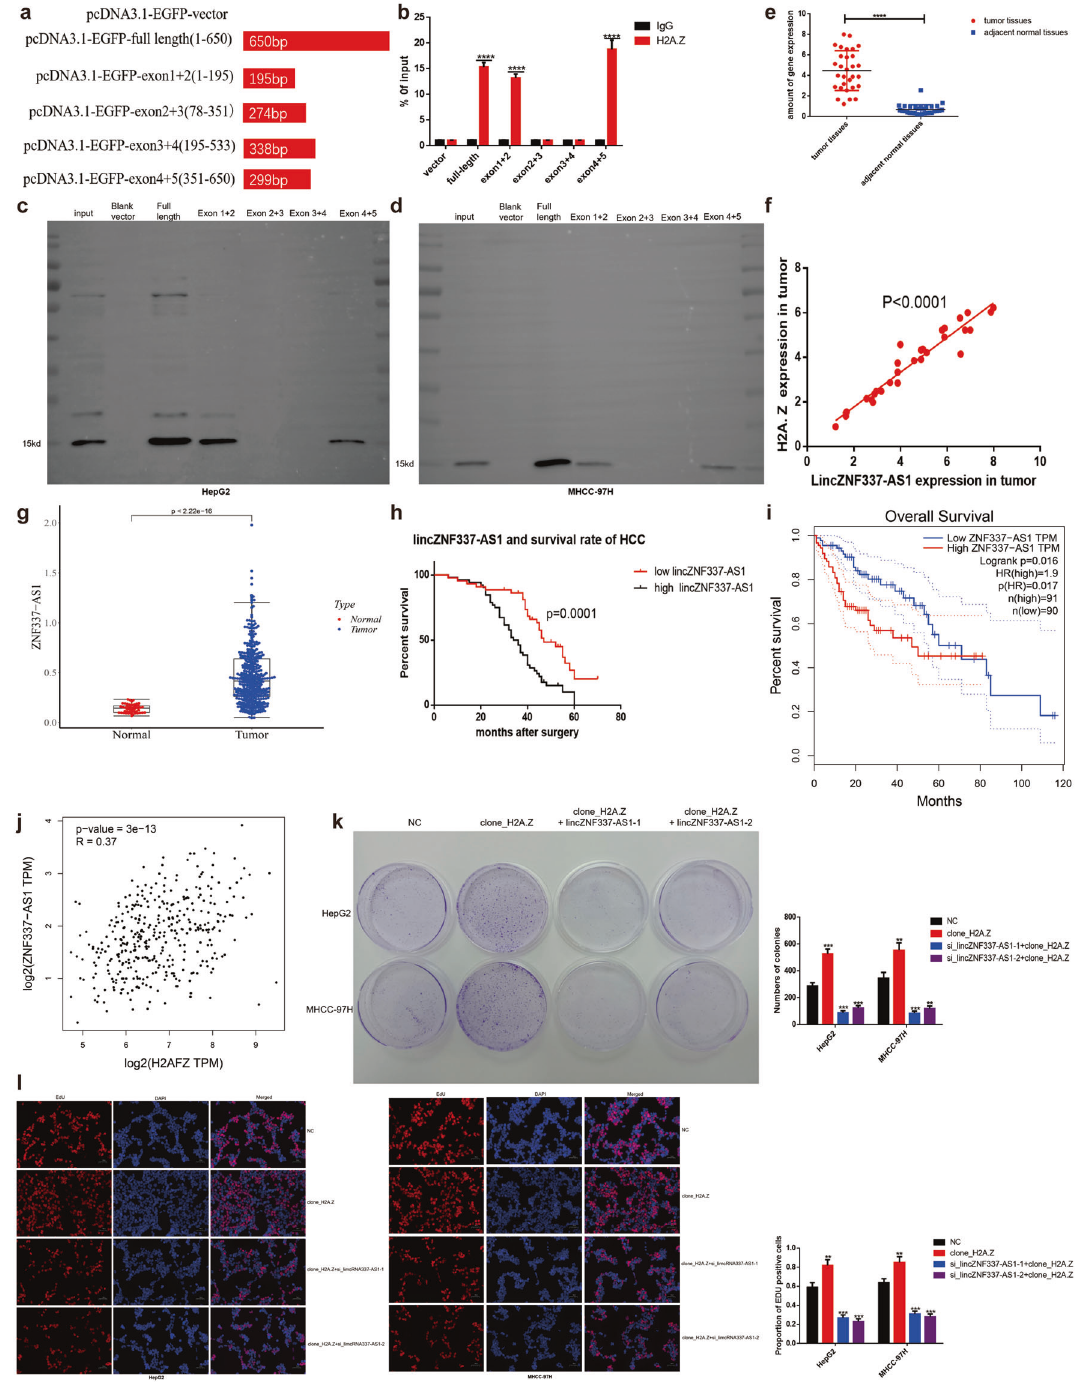
Fig. 6 Identi fi cation of lincZNF337-AS1 binding sites to H2A.Z, identi fi cation of lincZNF337-AS1 expression levels in HCC, and relationship with prognosis of HCC patients. a Schematic diagram of lincZNF337-AS1 full-length and truncated fragments. b The interaction of lincZNF337-AS1 truncated fragments with H2A.Z in HEK293T cells was veri fi ed by a RIP-qPCR assay. c , d RNA-pulldown assay veri fi es the binding site of lincZNF337-AS1 to H2A.Z in HCC cells. e Scatter plots comparing lincZNF337-AS1 expression in HCC samples and normal liver tissue samples detected by qPCR (Student ’ s t-test used in Fig e , n = 30 in each group). f The positive correlation between lincZNF337-AS1 and H2A.Z expression was analyzed on the basis of data of 30 HCC samples. g LincZNF337-AS1 transcript between HCC tissues and normal paracancer tissues was analyzed in the publicly accessible samples(TCGA http://gepia.cancer-pku.cn/, T = 375; N = 50, Software: beeswarm, R package). h Kaplan – Meier survival curves illustrating the overall survival and disease-free survival of patients with HCC associated with lincZNF337-AS1 expression in 96 cases. i The negative correlation between lincZNF337-AS1 expression and overall survival was analyzed on the basis of TCGA data in patients with HCC(Software: survival, R package). j The positive correlation between lincZNF337-AS1 and H2A.Z expression was analyzed on the basis of TCGA data in patients with HCC(Software: ggplot2, R package). k , l The proliferation capability of cells was detected by colony formation assay and EdU assay (scale bar = 50 μ m). The data are expressed in terms of mean ± SD (Student ’ s t -test used in b , k , and l ; Kaplan-Meier test used in g ; Linear regression test used in j ; **** P < 0.0001; n = 3 in each